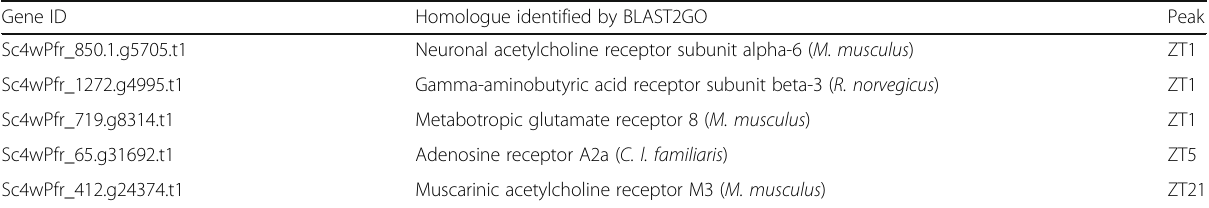
Table 2 Putative neurotransmitter receptor genes exhibiting diel expression patterns Gene ID Homologue identified by BLAST2GO Peak